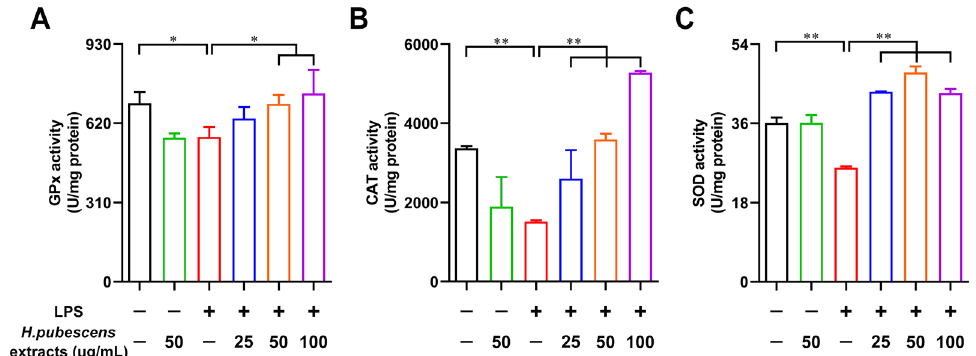
Figure 4. H. pubescens extracts strengthened the capacities of antioxidant enzymes in LPS-irritated DCs. DCs were collected and washed with PBS after being cultured with the designed concentrations of H. pubescens extracts or LPS (100 ng/mL) for 24 h. The intracellular GPx capacity ( A ), CAT capacity ( B ), and SOD capacity ( C ) of the DC lysate supernatant were tested using commercial kits. All of the data are shown as means ± SD from three experiments. Analysis of variance (ANOVA) was employed. ** p < 0.01, * p < 0.05.